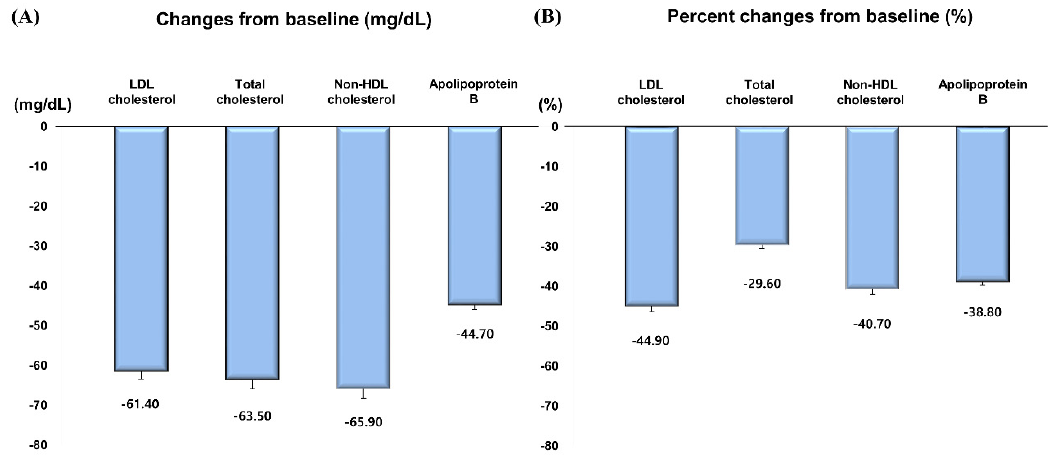
Figure 2. Changes in LDL cholesterol, total cholesterol, non-HDL cholesterol and apolipoprotein B in 8 weeks. ( A ) Changes from baseline. ( B ) Percent changes from baseline. HDL: high-density lipoprotein. Achievement of ≥ 50% reduction in LDL cholesterol by rosuvastatin 10 mg was 46.3% (112 / 242) in all patients. A comparison of subjects who reached 50% LDL cholesterol reduction versus others was performed (Table 3) in patients whose compliance was greater than 75%. The prevalence of comorbidities and rates of inclusion criteria were not significantly di ff erent between groups, except history of dyslipidemia. The subjects who achieved LDL reduction ≥ 50% (109 / 237, 46.0%) had higher baseline lipid values, except triglyceride (Table 3), and showed higher reduction in total cholesterol, triglyceride, non-HDL cholesterol and apolipoprotein B (Table 4). Meanwhile, the subjects who achieved LDL reduction ≥ 50% showed a lower increase in apolipoprotein A1 and lower but not significant increase in HDL cholesterol (Table